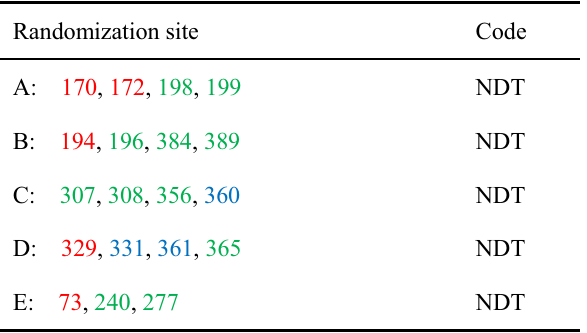
Table 1 Grouping of the 19 chosen Ec MAL residues into five randomization sites (A, B, C, D and E) and the NDT codes used in saturation mutagenesis